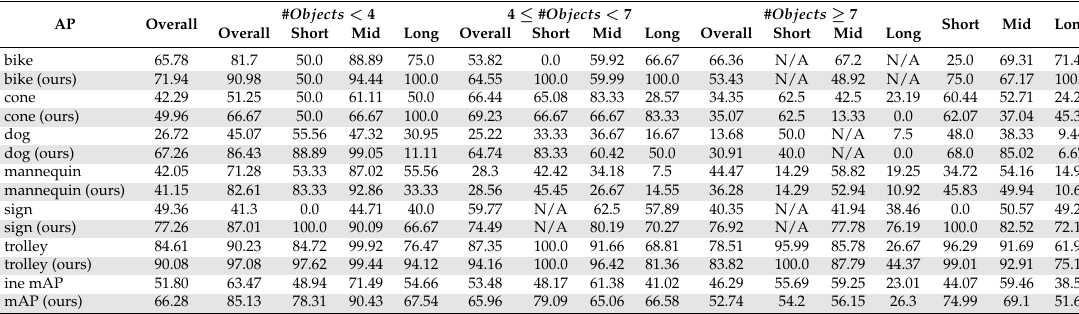
Table 6. Perfect detection: in white, the standard data augmentation is shown; in gray, our RADIO technique. The entry N/A means that there were no examples in the dataset.